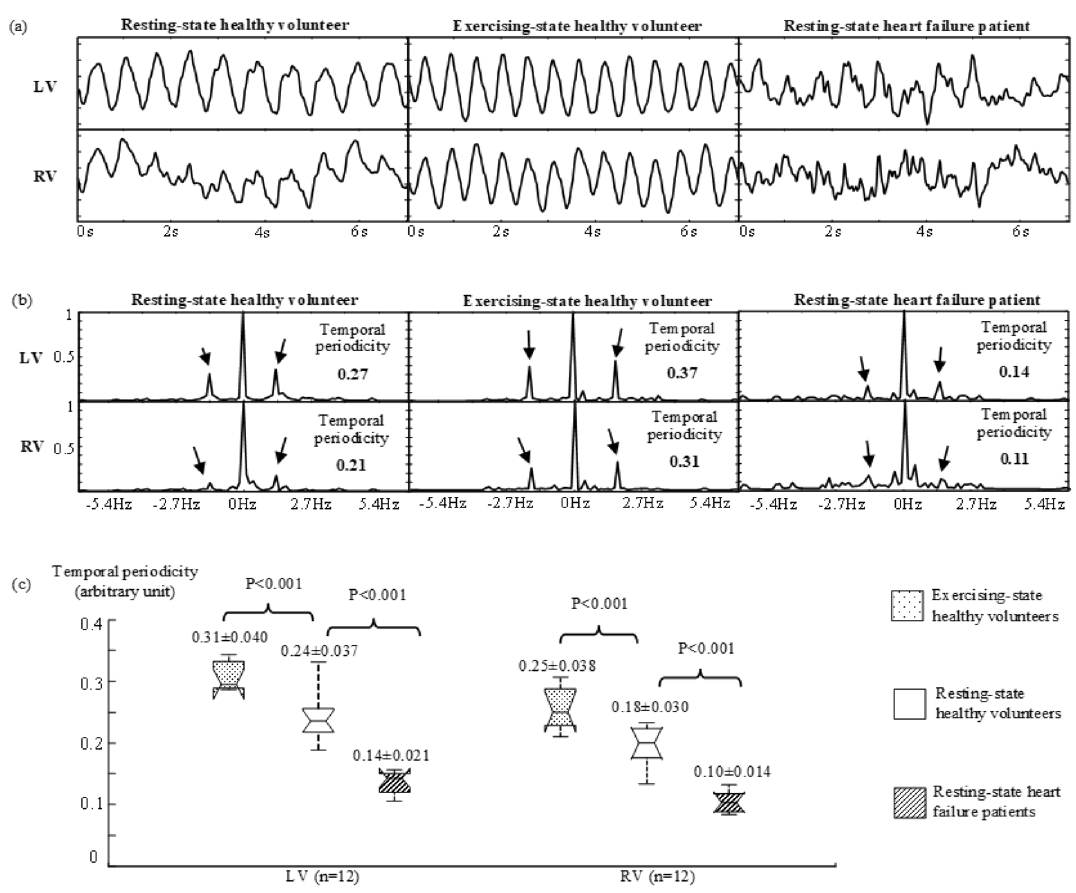
Figure 3. ( a ) Examples of reference wall-motion signals within LV-ROI (top row), and RV-ROI (bottom row). The unit on vertical axes is arbitrary. ( b ) Fourier transforms of the reference wall-motion signals in ( a ). The spectral magnitudes are normalized with respect to the zero-frequency component. The arrows indicate the cardiac frequency components for measuring temporal periodicity. ( c ) Box plots of the temporal periodicity measurements in real-time images from the healthy volunteers and HF patients. Each box provides the median, 25th and 75th percentiles of the measurements and the numbers give the mean ± standard deviation, and the t -test P values (n = 12).